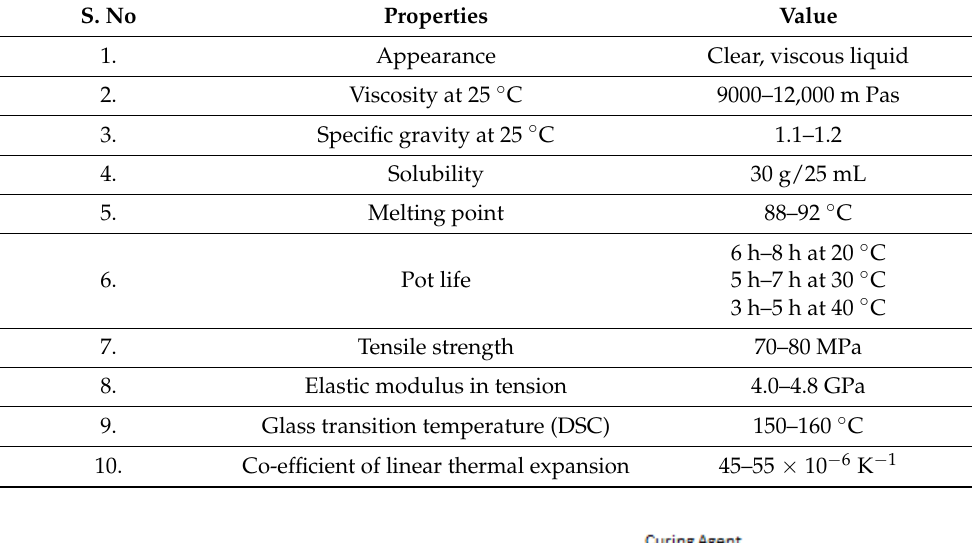
Table 1. Properties of Lapox L12.